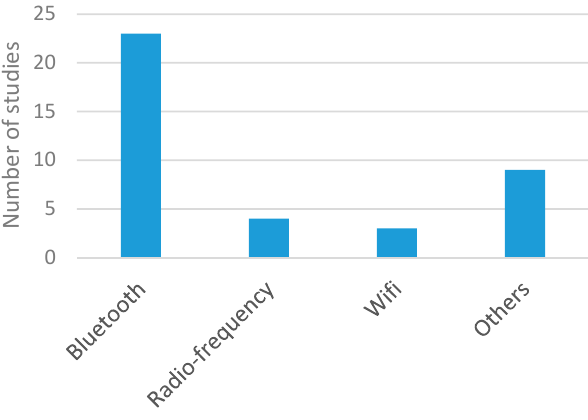
Figure 21. Number of respiratory monitoring studies that considered different types of communication technologies.